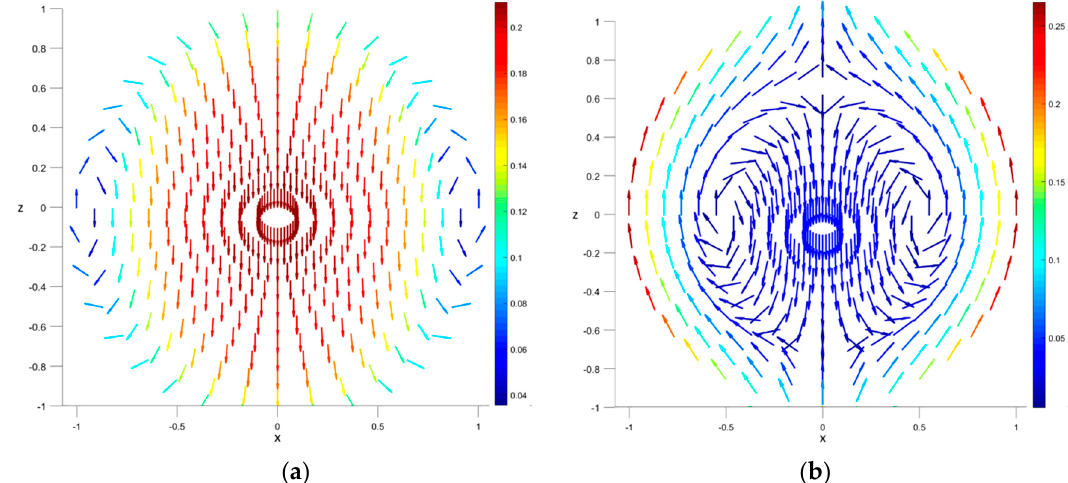
Figure 15. Rotamak mathematical analysis results: ( a ) poloidal field lines produced by rotating magnetic field (RMF) only; ( b ) field reversed configuration (FRC) which forms after adding a vertical magnetic field. The magnitude of the field at every point in space is indicated by the color bar in arbitrary units, relative to the magnitude of the applied RMF field.